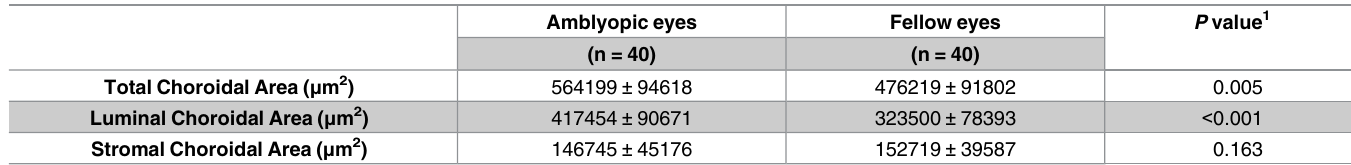
Table 2. Choroidal area of the amblyopic and fellow eyes.